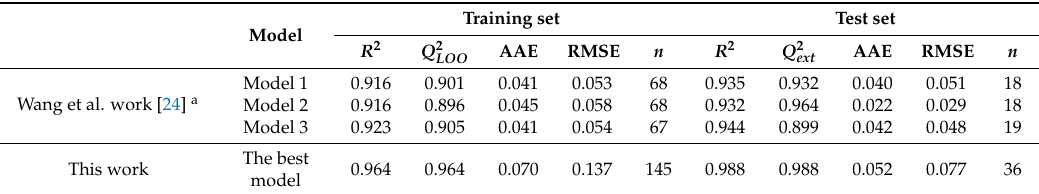
Table 4. Comparison of statistical parameters between the presented model and previous ones. Training set Model